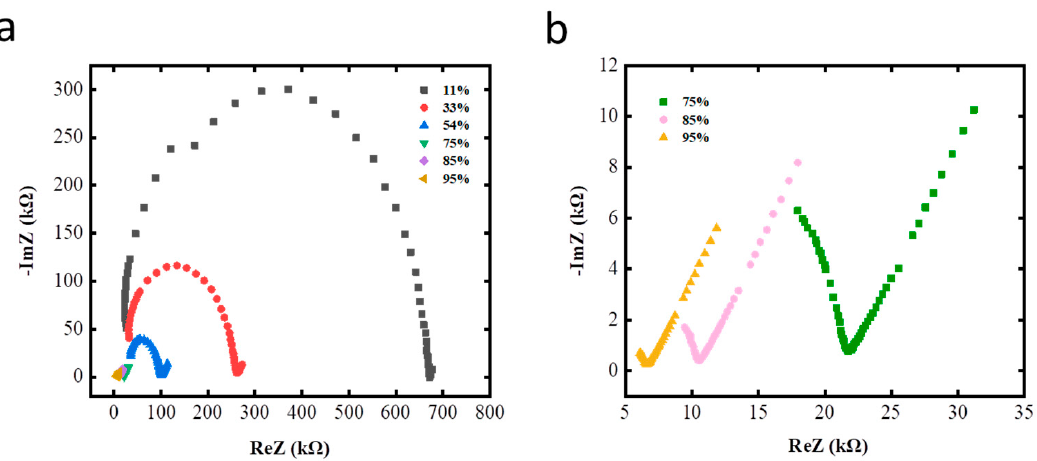
Figure 6. Complex impedance plots of the GO-based sensor at ( a ) RH values from 11–95%, ( b ) RH values from 75–95%. ImZ: imaginary part of complex impedance; ReZ: real part of complex imped-